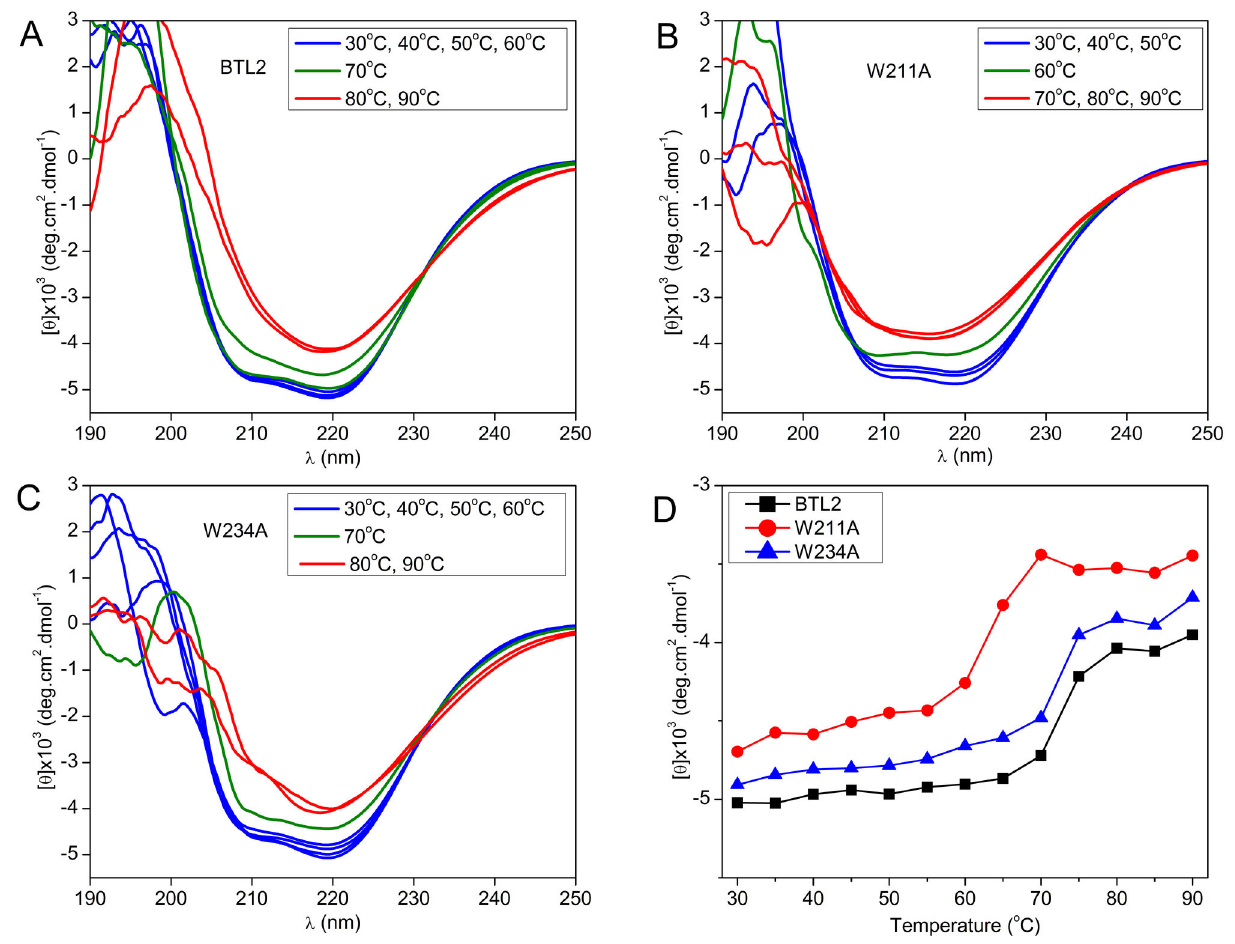
Figure 4. CD-spectra and thermal denaturation. The far UV CD-spectra collected at various temperatures are shown for the lipases (A) BTL2, (B) W211A, (C) W234A, and (D) mean residue ellipticity at 222 nm is plotted as a function of temperature.